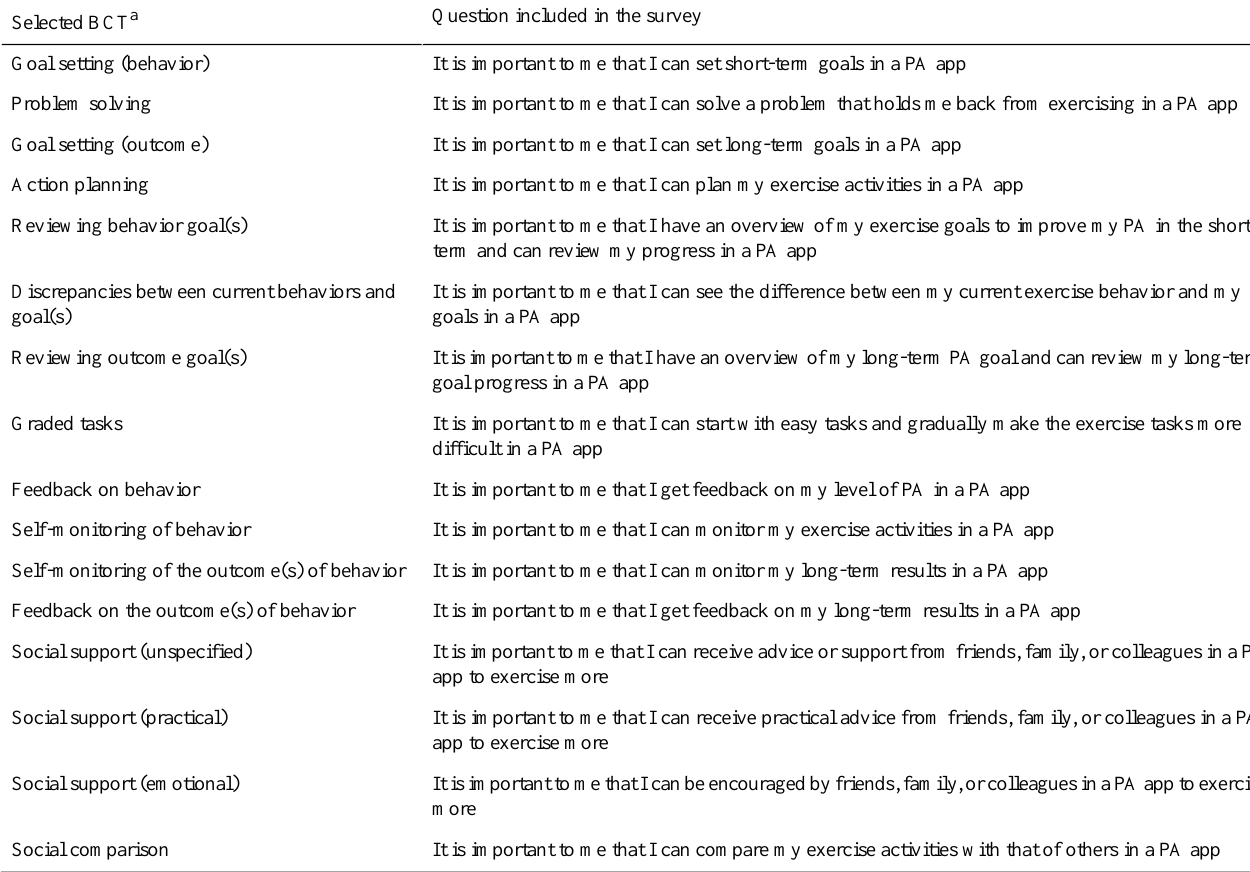
Table 1. Selected behavior change techniques (BCTs) included in the online